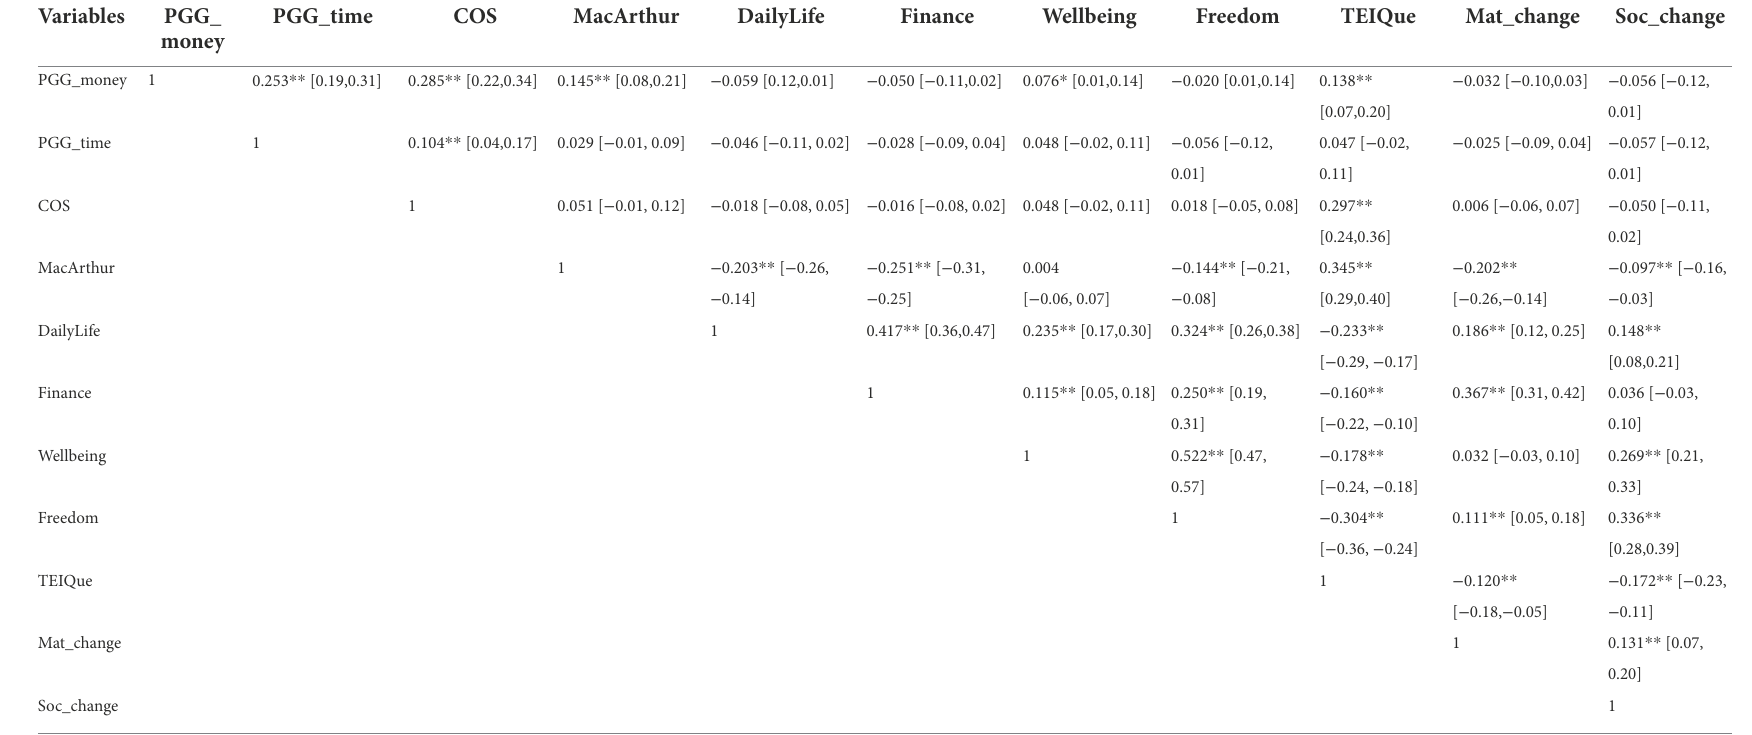
TABLE 5 Intercorrelations among regression variables ( r coefficients [lower and upper 95% CI]).